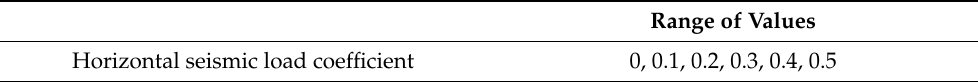
Table 7. The range of values for the horizontal seismic load coefficient in